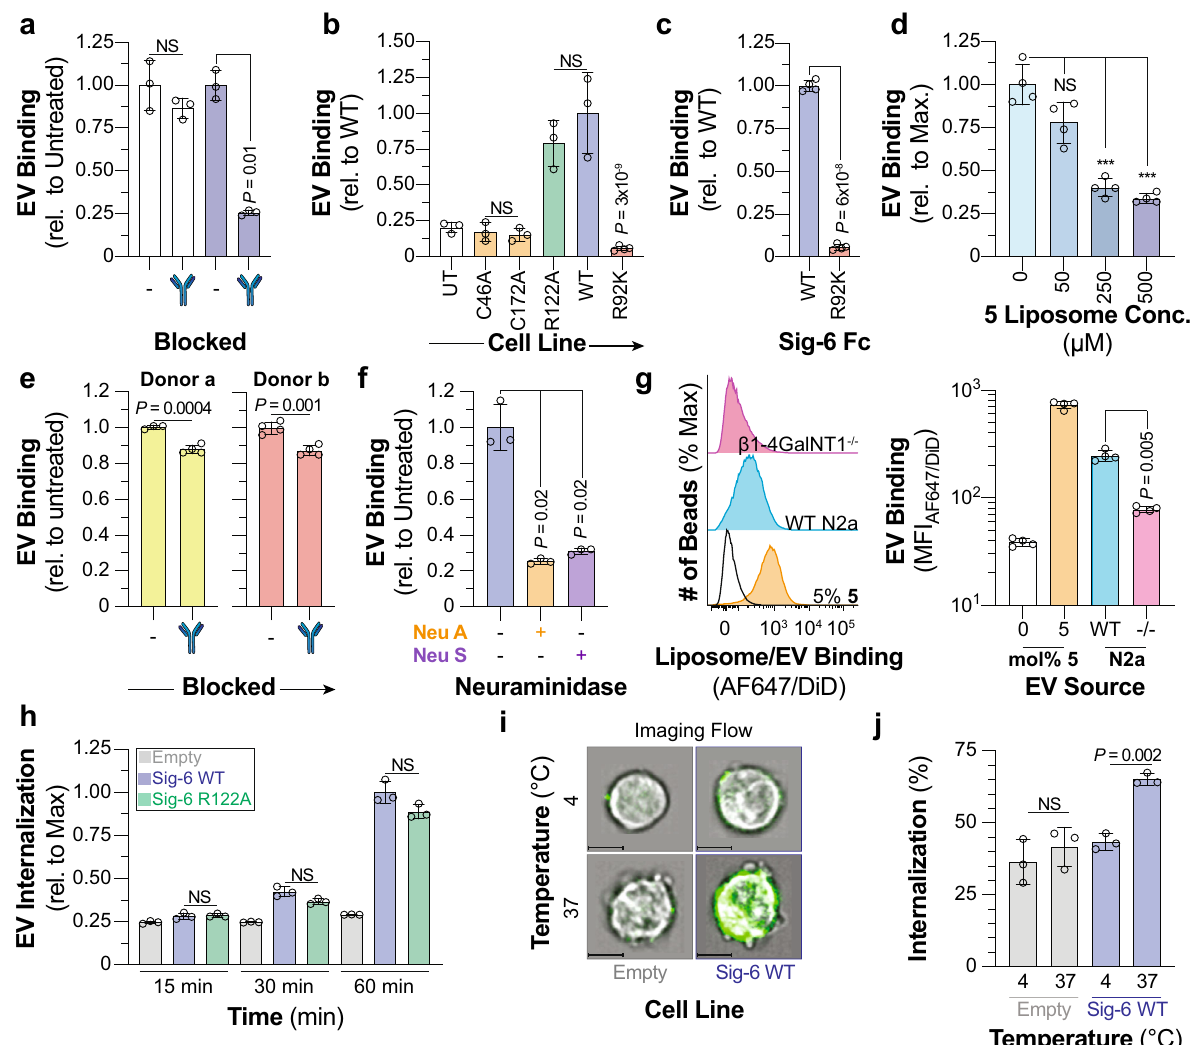
Fig. 6 | Siglec-6 binds and internalizes extracellular vesicles through glycoli- pids independent of its conserved arginine residue. a Binding of EVs to Siglec-6 expressing CHO cells pre-treated with an anti-Siglec-6 antibody ( n =3 technical replicates). b Binding of EVs to UT CHO cells and CHO cells expressing C46A, C172A, WT, R122A, and R92K Siglec-6 (4 ≥ n ≥ 3 technical replicates). c , Binding of EVs to WT and R92K Siglec-6 in the bead assay ( n =4 technical replicates). d Blocking of EV binding to Siglec-6 with 5mol% 5 nGLLs in the bead assay ( n =4 technical replicates). e Binding of EVs isolated from two different donors to LAD2 cellspretreatedwithananti-Siglec-6antibody( n =4technicalreplicates). f Binding of neuraminidase A and neuraminidase S treated EVs to Siglec-6 in the bead assay ( n =3technicalreplicates). g BindingofEVsisolatedfromWTand β 1-4GalNT1 − / − N2a cells to WT Siglec − 6 in the bead assay ( n =4 technical replicates). h Time-